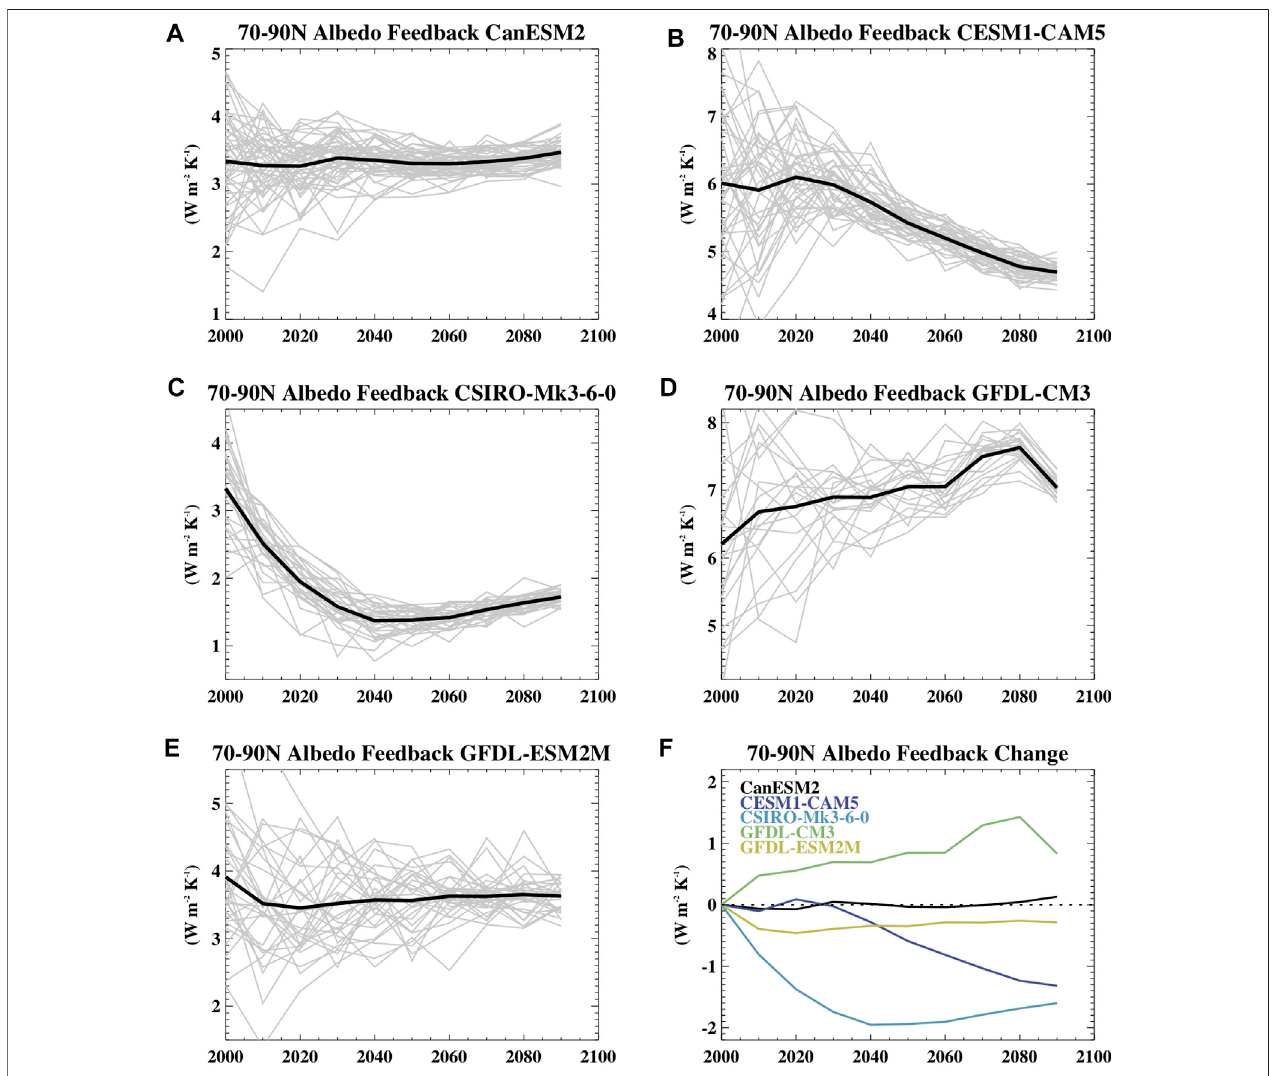
FIGURE 8 | The 70 – 90N annual decadal mean surface albedo feedback in models that had shortwave terms available including for (A) CanESM2, (B) CESM1- CAM5, (C) CSIRO-Mk-3-6-0, (D) GFDL-CM3, and (E) GFDL-ESM2M. The fi nal panel (F) shows the change in the ensemble mean albedo feedback over the 21st century computed as the ensemble mean values for the 2090 – 2099 average minus the 2000 – 2009 average to allow comparison across the models. For panels (A – E) , individual ensemble members are shown in grey and the ensemble mean in black.